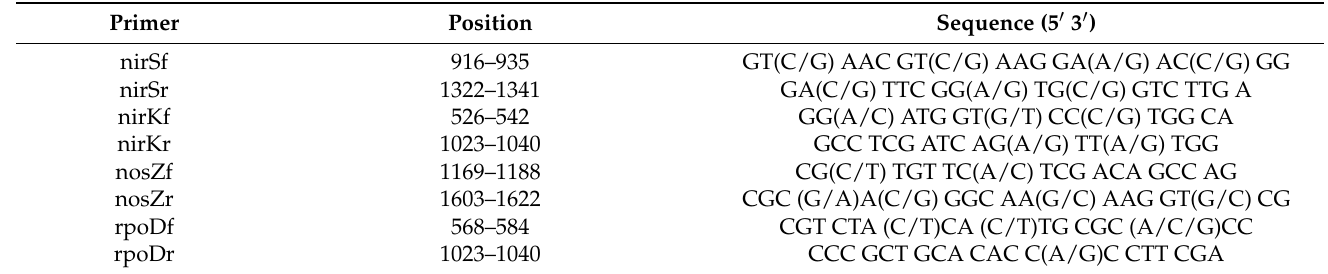
Table 2. Primers for NirK and NirS and housekeeping control gene.